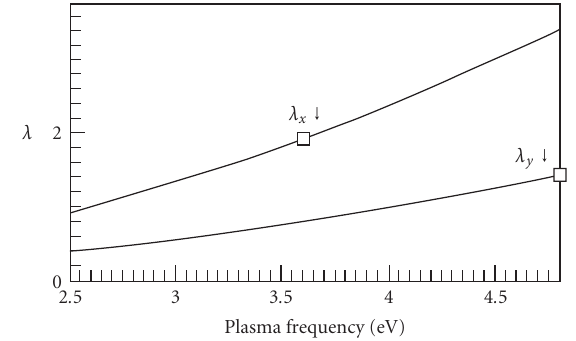
Figure 13: Transport EPI spectral function coupling constant in YBCO as a function of plasma frequency ω p as derived from the experimental slope of resistivity ρ (cid:6) ( T ) . λ x for ρ (cid:6) ( T ) = 0 . 25 μ Ω cm / K [119]. Squares are LDA values and λ y for ρ (cid:6) y